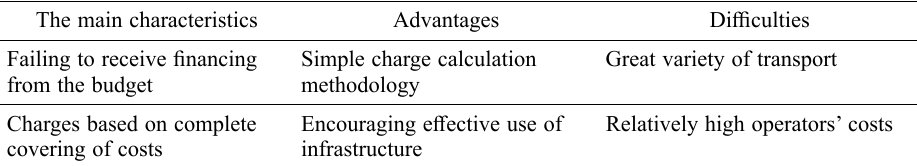
Table 3. Summary of the charge system for using